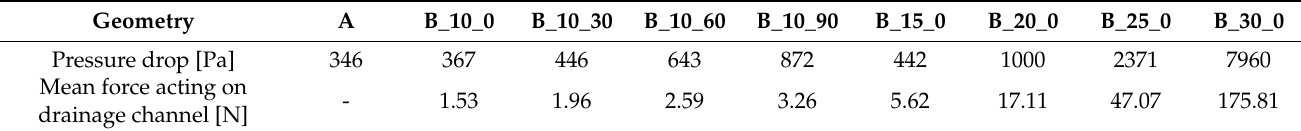
Table 12. Pressure drops on mist eliminators and the mean force acting on drainage channel; inlet velocity 4 m s − 1 .